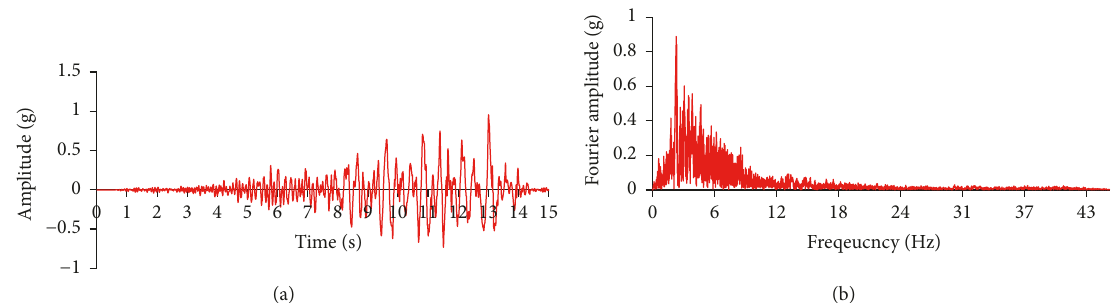
Figure 12: The acceleration and acceleration spectral curve after modification. (a) Acceleration time history curve; (b) Fourier spectral (EW)